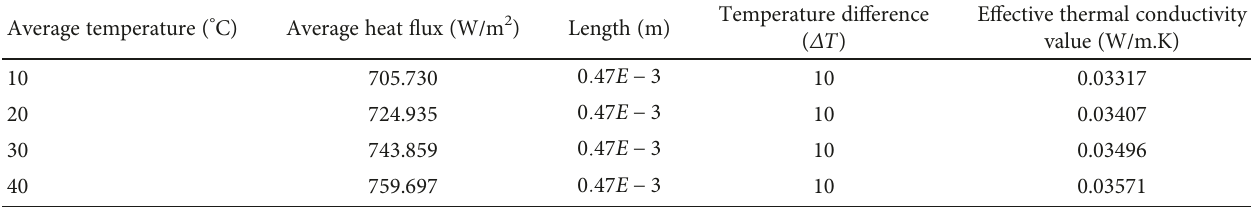
Table 5: The numerical solution results for the expanded polystyrene with the density value of 21kg/m 3 . Average temperature ( ° C)